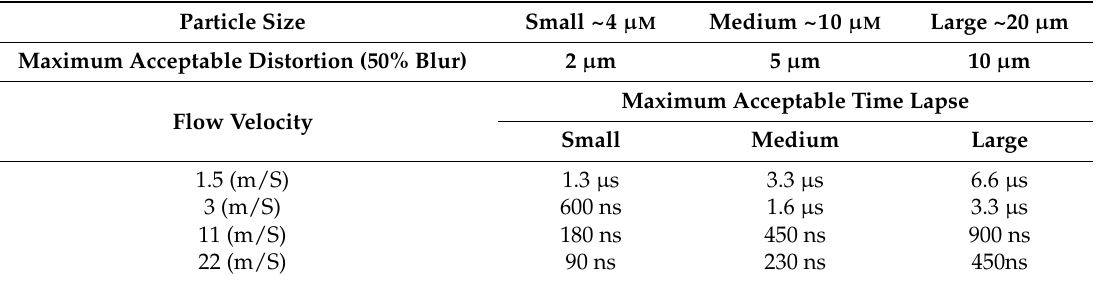
Table 2. Maximum Time Lapse for Illuminating a Moving